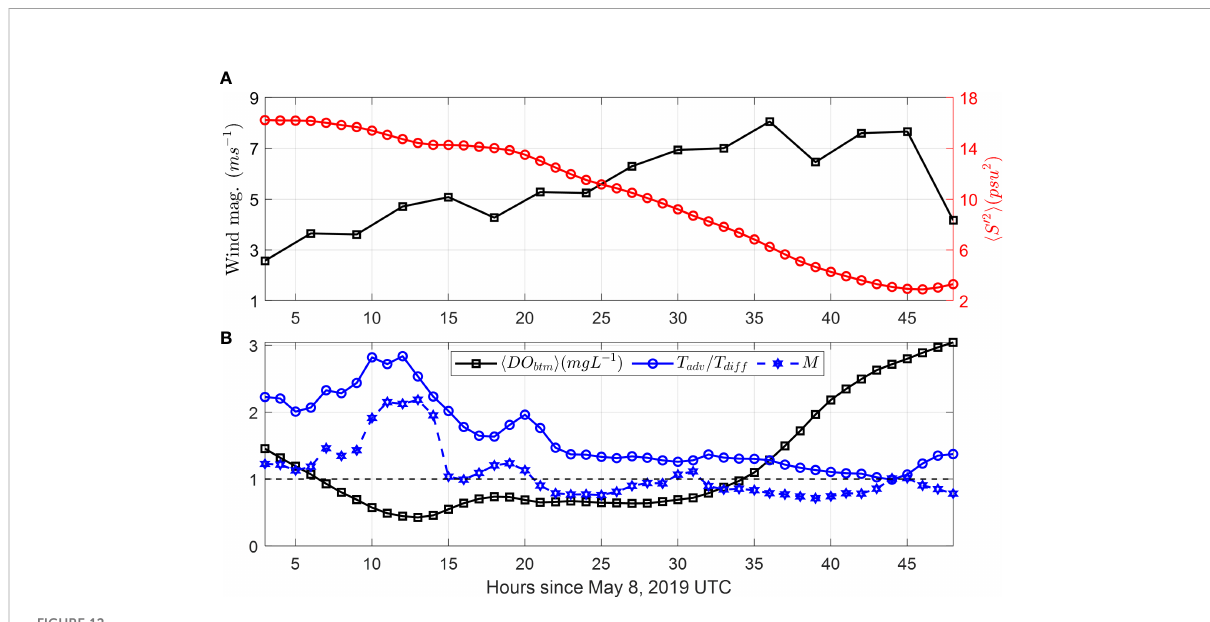
FIGURE 12 (A) Time series of magnitude wind speed and spatially averaged salinity variance 〈 S ′ 2 〉 under southeast wind. (B) Time series of bottom DO 〈 DO b 〉 , advection-diffusion scaling T adv e K z L fl ux ratio R dd = Q SOD T diff K z DO s = h sp . In panel (B) , dashed black line denotes u s h sp 2 , and demand-diffusion and R dd = 1. In panels (A, B) , spatial averaging zone is shown by the thick black box in Figure